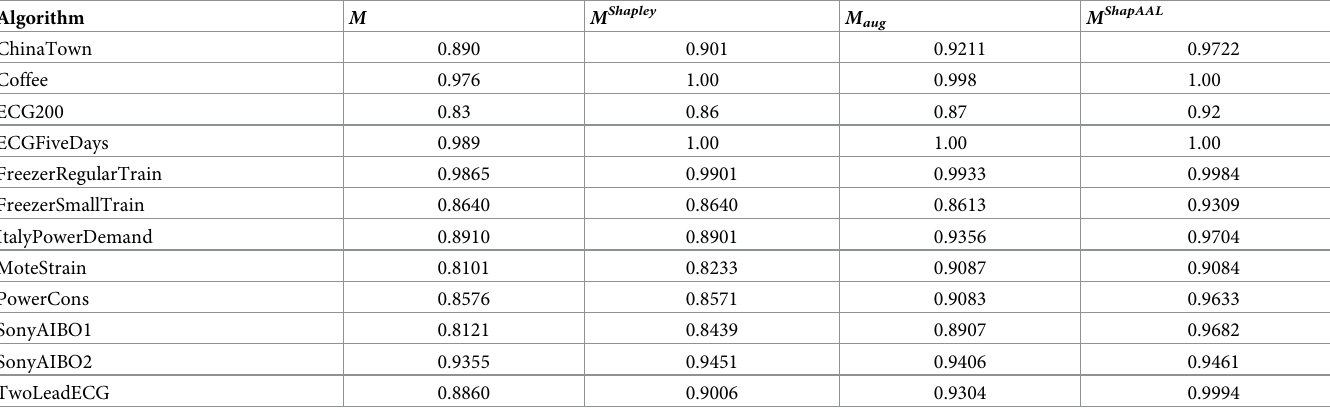
Table 2. Ablation study through test accuracies of ShapAAL model ( M ShapAAL ) with M , M Shapley , M aug . Algorithm